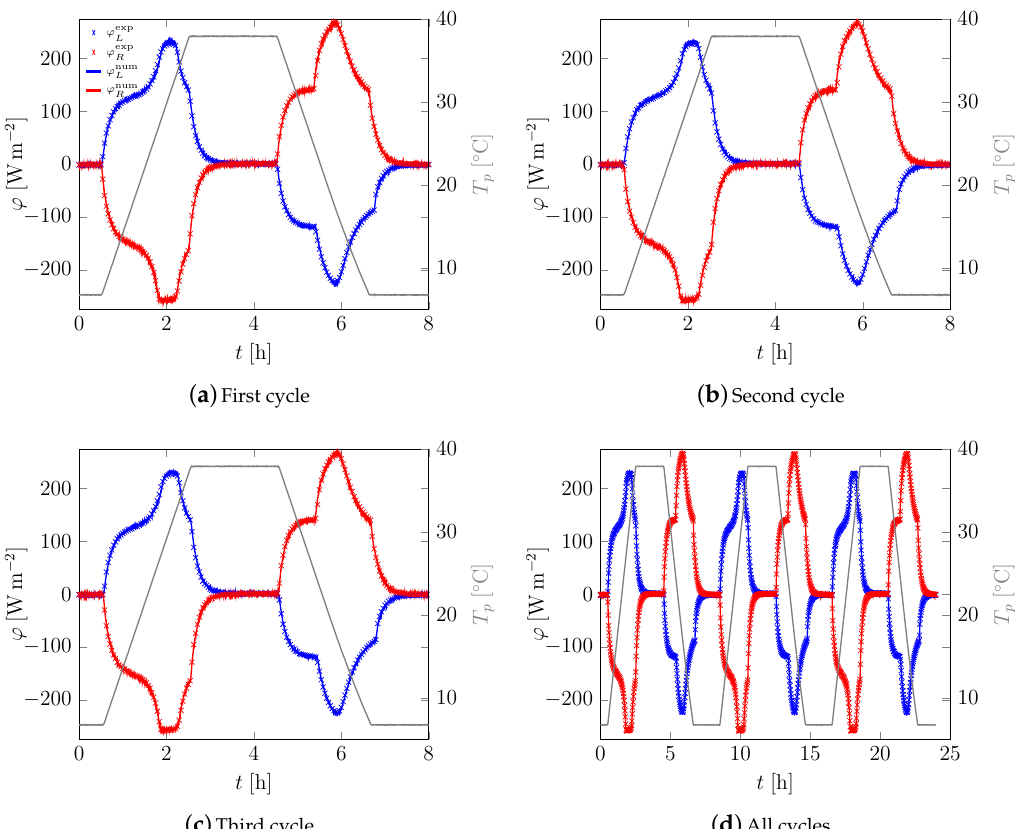
Figure 7. 12.4% w -PCM mortar: comparisons of the experimental fluxes with the numerical ones after identification for the 2h heating/cooling ramp